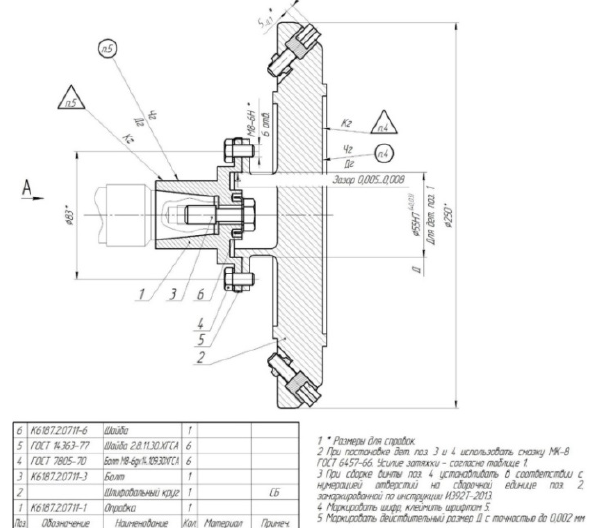
Fig. 5. Grinding wheel for ultra-fast grinding with horizontal machining units